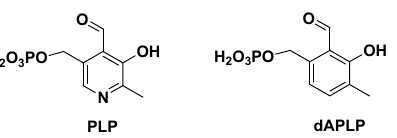
Figure 1. Chemical structures of PLP and 1-deaza-PLP (dAPLP). PLP-dependent enzymes (henceforth referred to as PLPoenzymes following the analogy of metalloenzyme and flavoenzyme) can be classified into five different families depending upon their respective folds. Aspartate aminotransferase (AAT), tryptophan synthase, alanine racemase (AR), D-amino acid aminotransferase, and glycogen phosphorylase represent enzymes of fold types I, II, III, IV, and V, respectively [12]. There is another type of PLPoenzymes which cannot be placed into any of these five families. Radical aminomutases such as lysine 5,6-aminomutase (5,6-LAM), ornithine 4,5-aminomutase (4,5-OAM), lysine 2,3-aminomutase (2,3-LAM), and glutamate 2,3-aminomutase (2,3-GAM), belong to this family [13,14]. The generation of a 5 (cid:48) -deoxyadenosyl radical (dAdo • ) is required